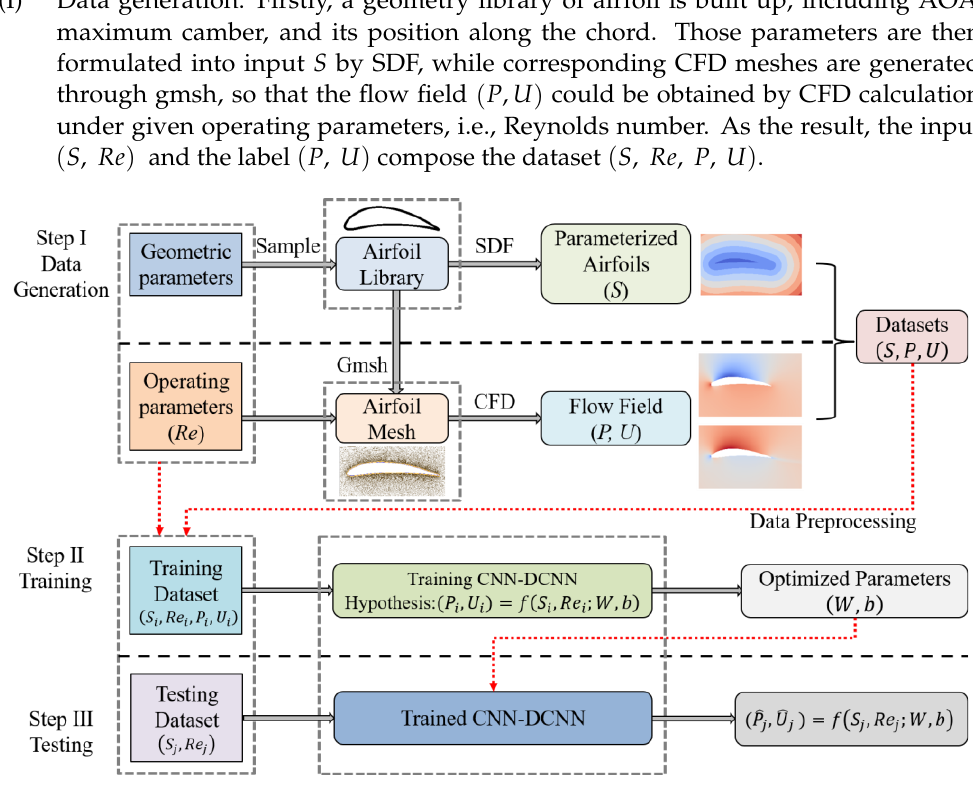
Figure 1. Overall architecture of CNN-DCNN framework.